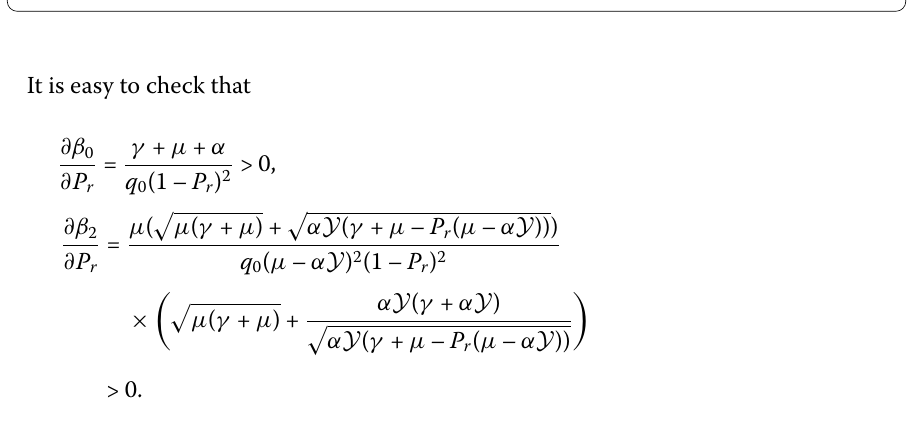
Figure 7 The critical successful contact rate β (cid:3) as a function of the maximum treatment capacity Y , for different levels of percent reduction (cid:2) P r . Below the curves, the infection does not persist, while above them the infection persists. The dashed curve is produced with a 12.5% reduction, the dotted curve is produced with 25% reduction, while the solid curve is drawn with 50% reduction in infected individuals’ contact-activity time. The values of the other parameters are as shown in Table 1. The critical contact rate β (cid:3) increases with the increase of (cid:2) P r